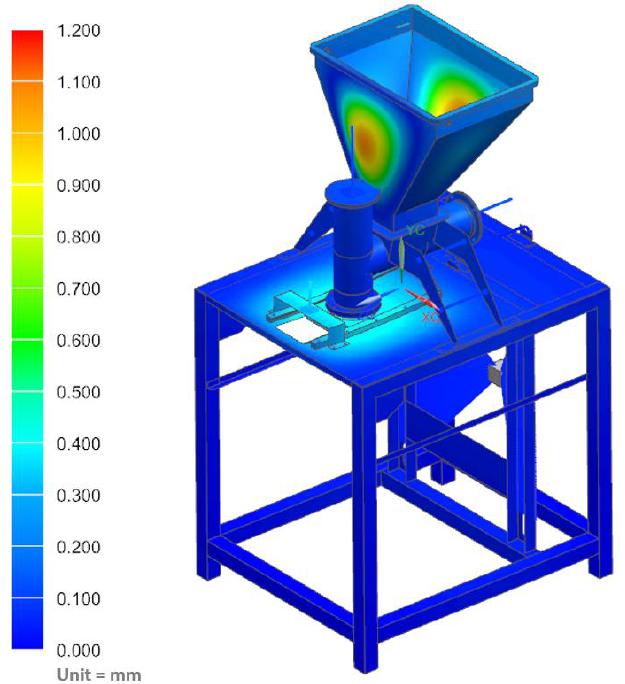
Figure 12. Displacement map of the molding module.